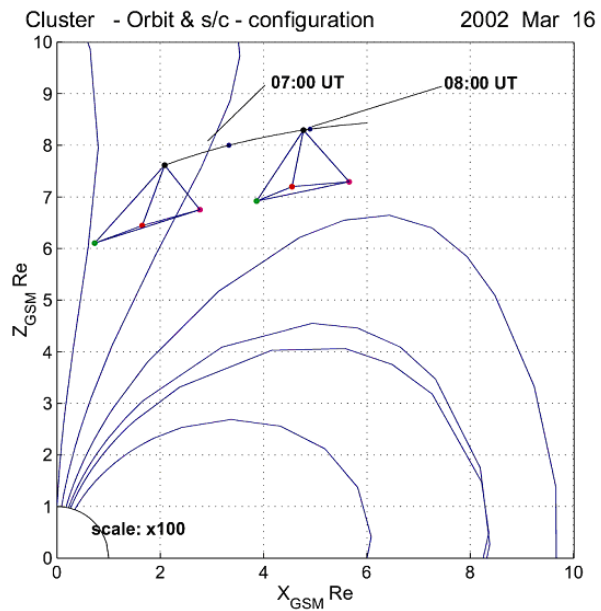
Fig. 1. Orbit of the Cluster fleet for the 16/03/2002 event, as de- scribed in Sect.